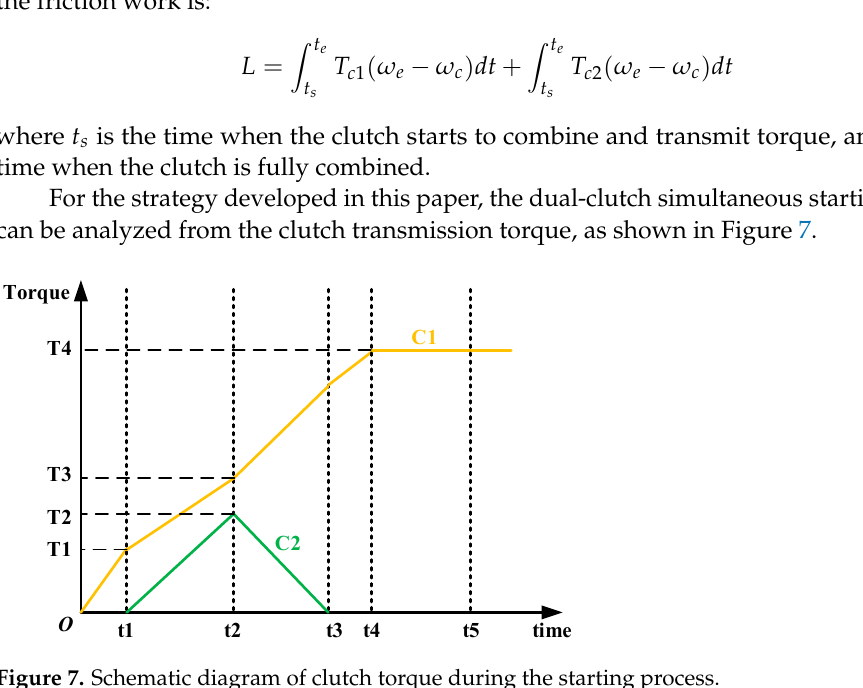
Figure 7. Schematic diagram of clutch torque during the starting process.